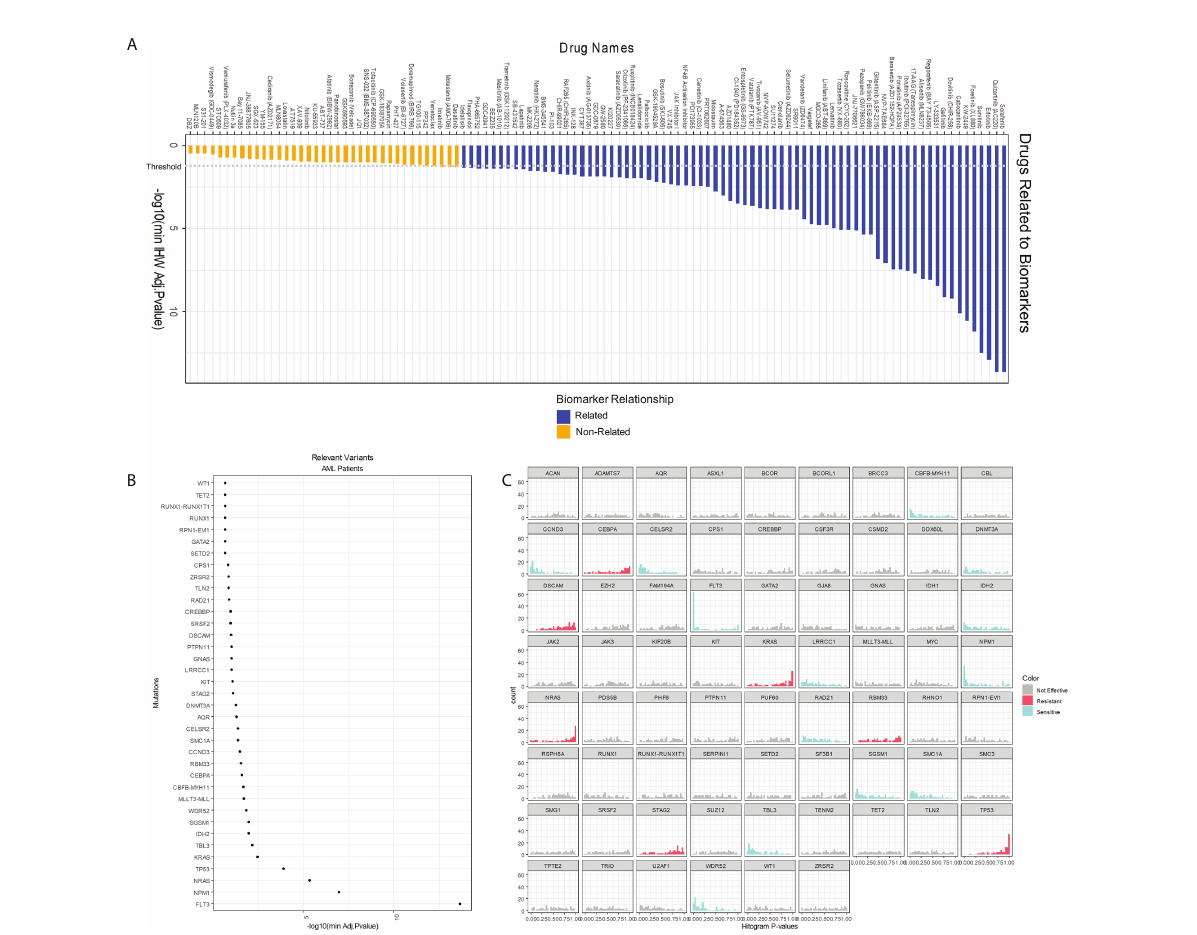
FIGURE 4 Analysis of single interactions biomarker-drug. (A) Overall score of 122 drugs whose IC50* is related or non-related to cell genotype according to our model. A drug is related to a relevant variant (those whose IHW weight is greater than zero) if its adjusted p-value is below 0.05. (B) Global effect of AML gene variants in AML drug sensitivity. The x-axis shows the logarithm of the minimum adjusted p-value of the biomarker with any of the drugs. Only those biomarkers whose IHW weight is greater than zero are shown. (C) One-tail p-value histograms comparing drug sensitivity according to the biomarker status in AML. If a histogram has a strong peak near zero, patients with the biomarker are sensitive to many drugs. On the contrary, if a histogram has a strong peak near one, patients with the biomarker are resistant to many drugs. A genetic variant is considered to confer sensitiveness if the number of drugs whose p-value<0.2 is twice the number of p-values >0.2. Similarly, a variant confers resistance if ful fi lls that the number of p- values>0.8 is twice the number of p-values<0.8. (IHW: Independent Hypothesis